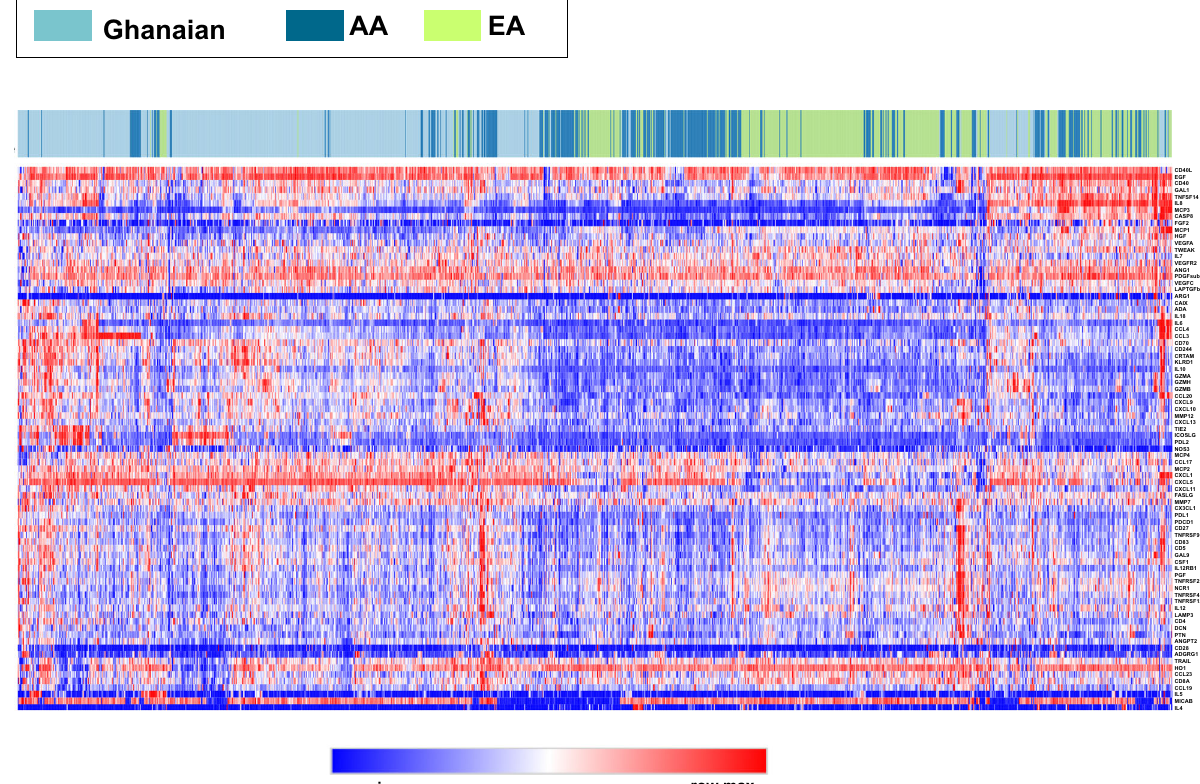
Fig. 3 Unsupervised hierarchical clustering associates circulating immune-oncological proteome pro fi les with population groups — Ghanaian, AA, and EA men. Heatmap showing protein pro fi les for men without prostate cancer. Each row represents a protein ( n = 82), and each column corresponds to an individual [ n = 1482 (654 Ghanaian, 374 AA, and 454 EA)]. Each individual is color-coded as Ghanaian, AA, or EA in the annotation bar on top of the heatmap. Normalized z -score of proteins abundance is depicted on a low-to-high scale (blue-white-red). Source data are provided as a Source Data fi le. AA African American and EA European